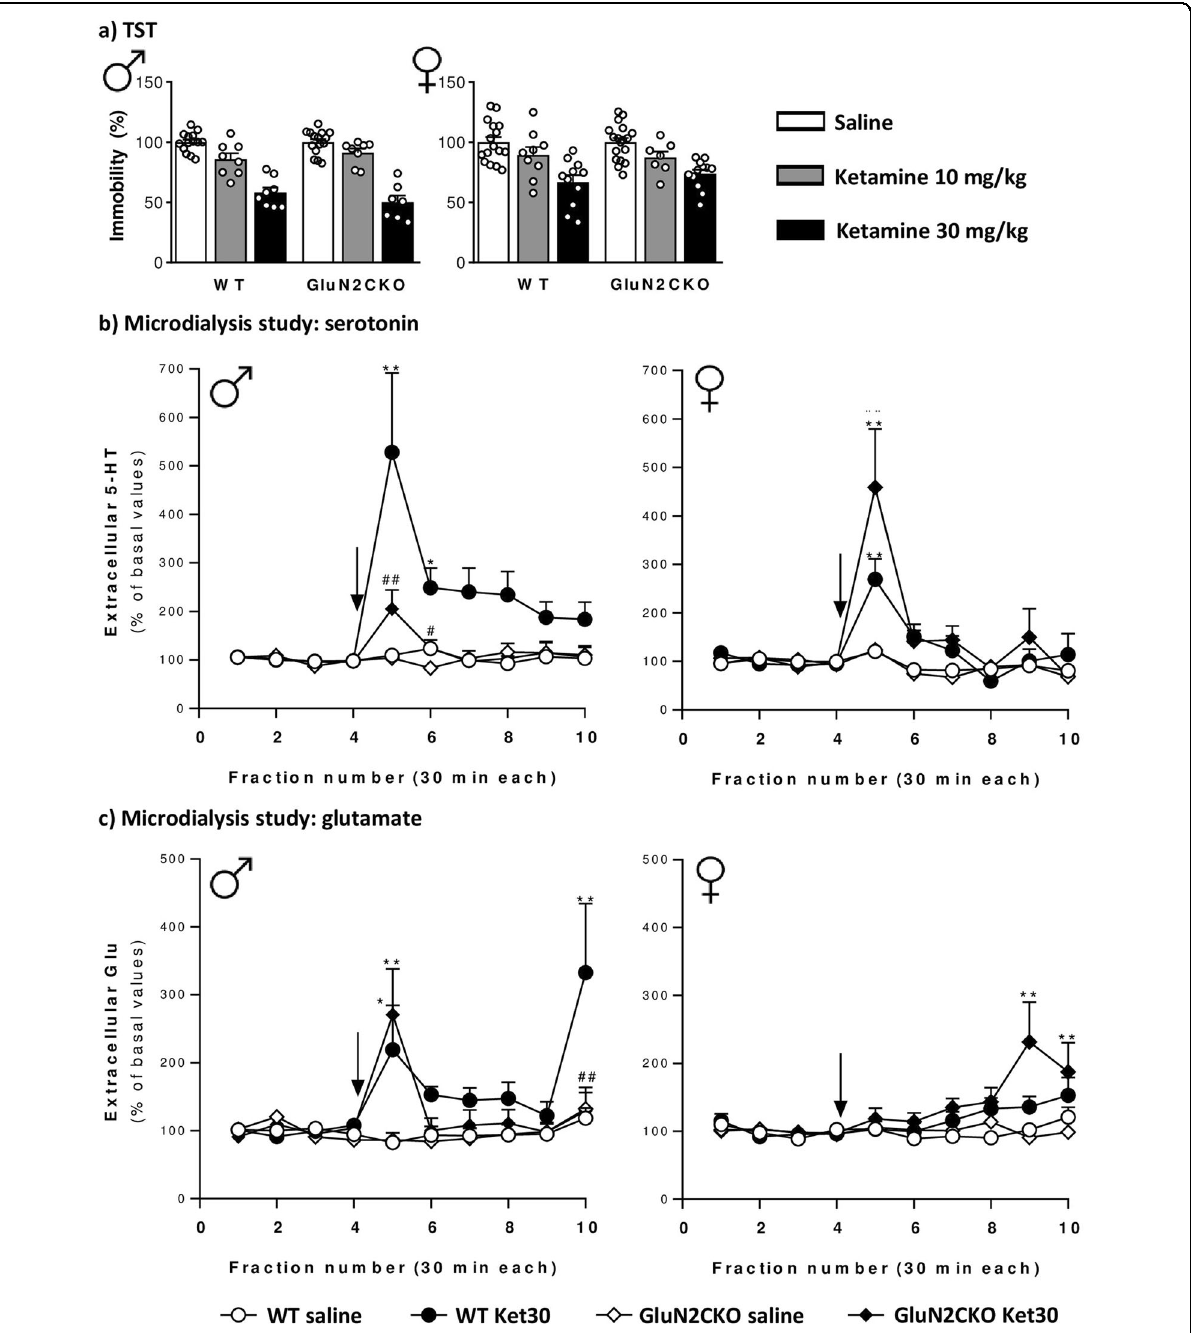
Fig. 2 Tail suspension test and microdyalisis study in WT and GluN2CKO mice of both genders. a Effects of ketamine (10 and 30 mg/kg) in male ( ♂ ) and female ( ♀ ) WT and GluN2CKO mice in the tail-suspension test (TST). Data are expressed as percentage of immobility from saline-treated mice. Male WT saline ( n = 14); male GluN2CKO saline ( n = 15); female WT saline ( n = 16); female GluN2CKO saline ( n = 18); male WT and GluN2CKO ketamine 10 and 30 mg/kg ( n = 8); female WT ketamine 10 mg/kg ( n = 9); female WT ketamine 30 mg/kg ( n = 11); female GluN2CKO ketamine 10 mg/kg ( n = 7); female GluN2CKO ketamine 30 mg/kg ( n = 12). b Time course of extracellular levels of serotonin (5-HT) in the medial prefrontal cortex (mPFC) after saline or 30 mg/kg of ketamine (Ket30) administration in male and female WT and GluN2CKO mice. Male WT and GluN2CKO saline and male GluN2CKO Ket30 ( n = 9); male WT Ket30 ( n = 8); female WT saline ( n = 13); female GluN2CKO saline ( n = 14); female WT and GluN2CKO Ket30 ( n = 11). c Time course of extracellular levels of glutamate (Glu) in the mPFC after saline or 30 mg/kg of ketamine (Ket30) administration in male and female WT and GluN2CKO mice. Male WT and GluN2CKO saline and Ket30 ( n = 9); female WT saline ( n = 12); female GluN2CKO saline ( n = 14); female WT Ket30 ( n = 11); female GluN2CKO Ket30 30 ( n = 13). Microdialysis data are expressed as percentage of four basal values (fractions 1 – 4). The values are expressed as mean ± SEM. The arrow represents the time of IP injection of saline or ketamine. Dialysate fractions were 30 min each. * p < 0.05, ** p < 0.01 vs. saline; # p < 0.05, ## p < 0.01 vs. WT (Newman – Keuls post hoc